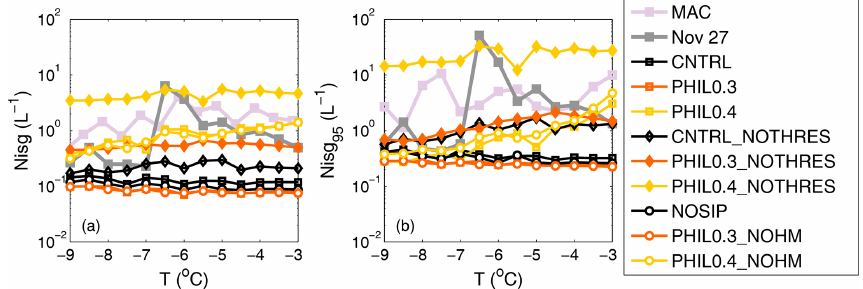
Figure 5. Total ice number concentrations ( N isg ) for particles > 80µm as a function of temperature for the whole MAC campaign (pink), our case study (gray) and the nine sensitivity simulations with varying treatments of the H-M process (see Sect. 4.3). Mean values and the 95th percentile are shown in panels (a) and (b) , respectively.